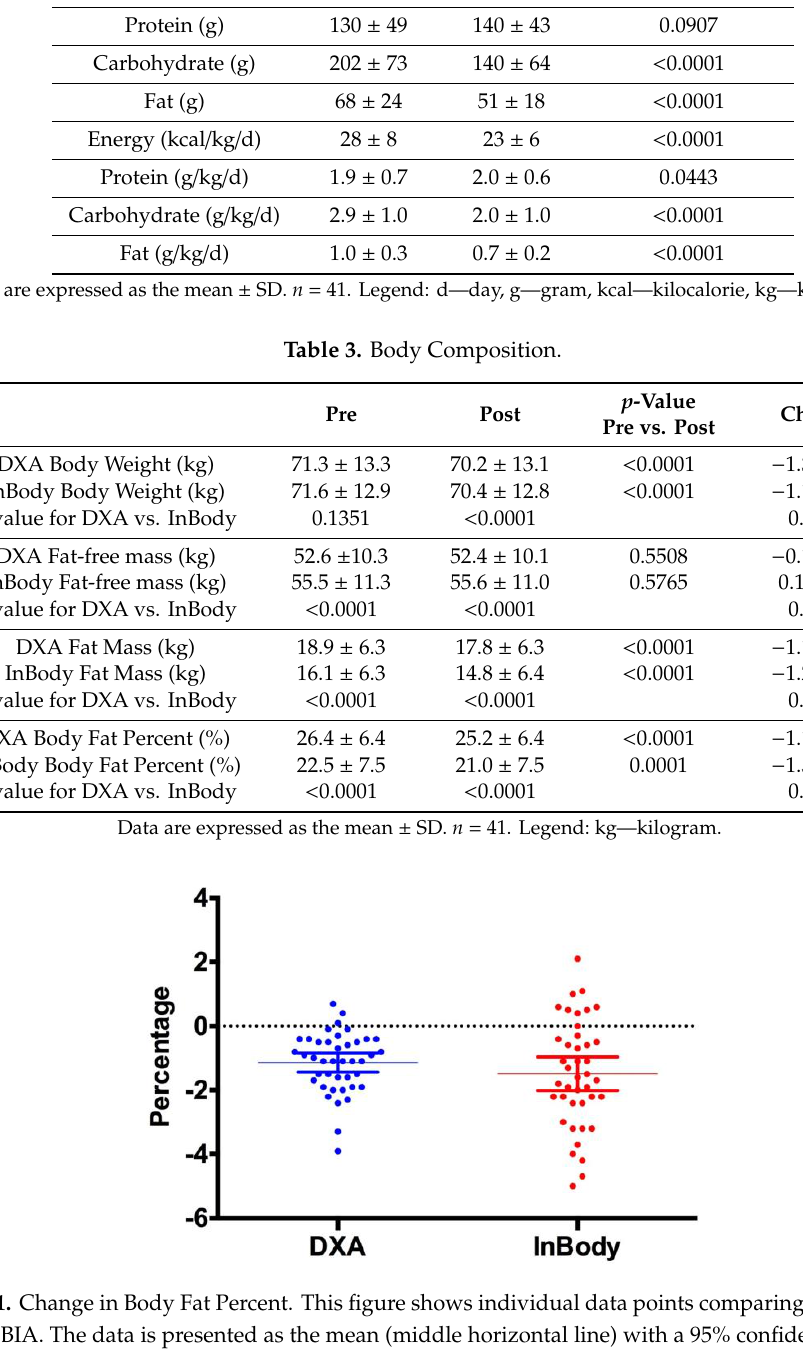
Table 3. Body Composition.